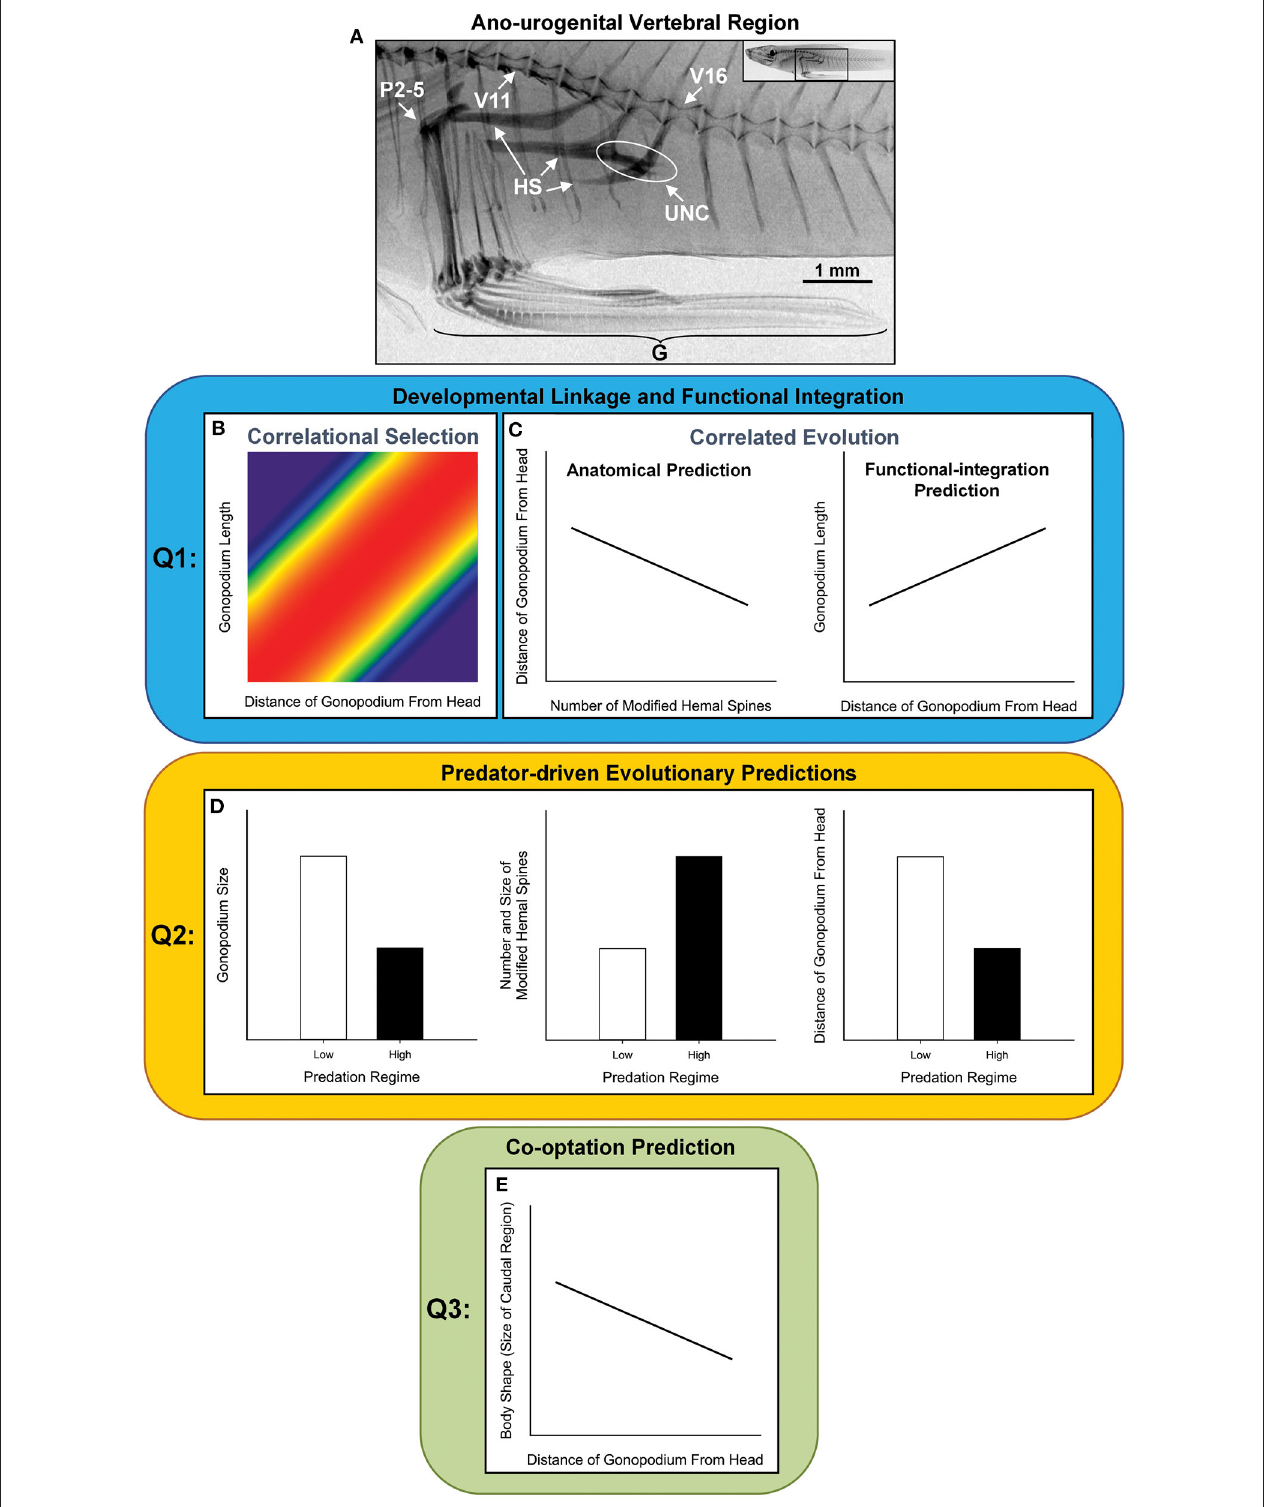
FIGURE 1 | Illustration of (A) the gonopodial complex in live-bearing fishes ( Gambusia affinis depicted), and hypothetical depictions of our (B) hypothesis of correlational selection on two gonopodial-complex traits, (C) predictions of correlated evolution among traits, (D) predictions of trait divergence between predation